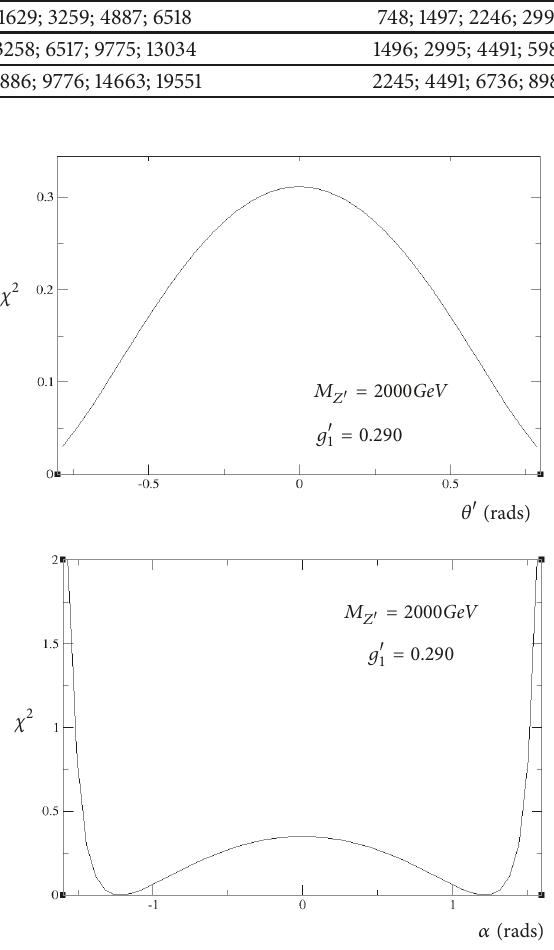
Figure 10: 𝜒 2 as a function of 𝑀 푍 󸀠 (𝑔 耠 1 ) .